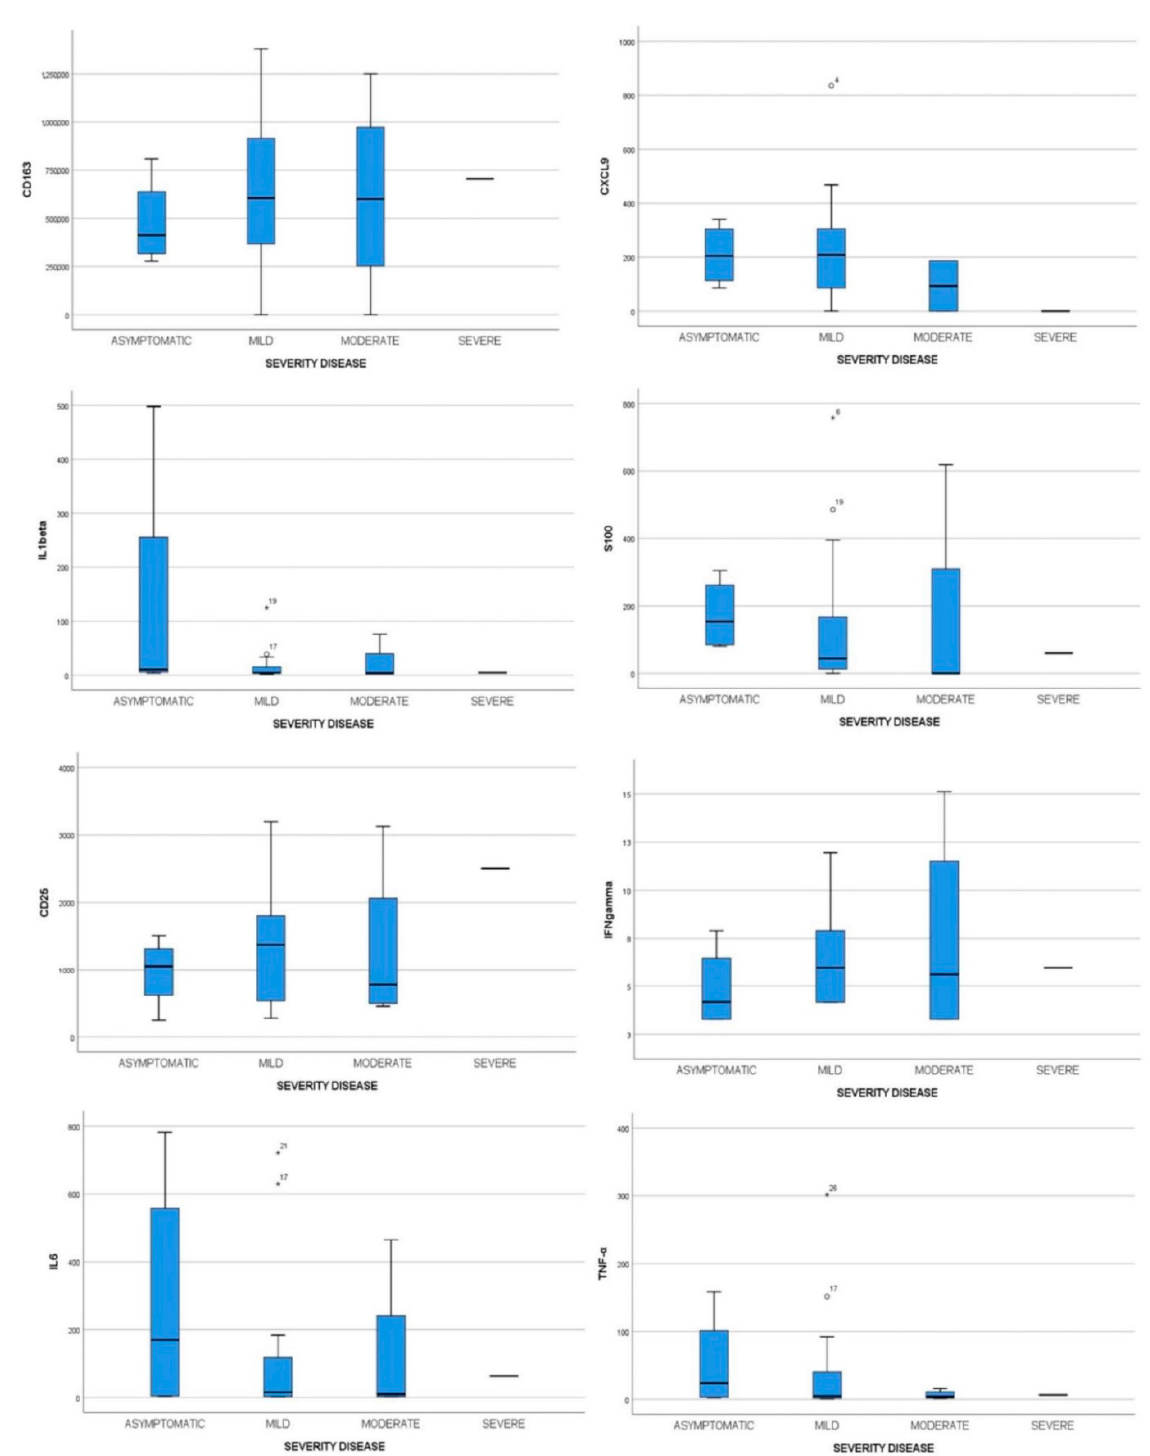
Figure 2. Cytokines evaluation in children affected by COVID-19 with different severity disease: asymptomatic, mild, moderate, and severe. Plasmatic levels of CD163, CXCL9, IL1 β , S100b, CD25, IFN- γ , TNF- α , and IL6 were measured by Bead Array flow cytometry assay on a single serum sample. ANOVA and Kruskal–Wallis comparison tests were used to compare values between different COVID-19 severities.